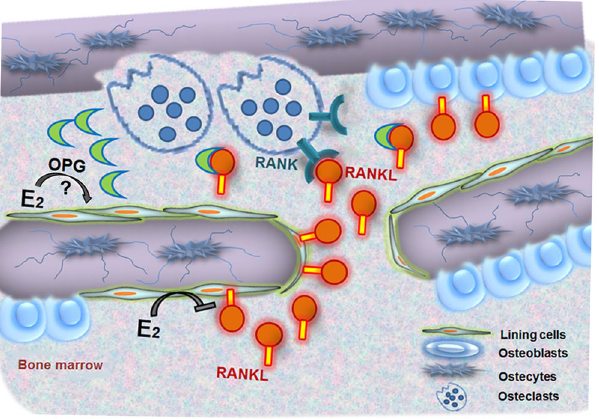
Figure 5. Model of how estrogen regulates osteoclastic bone resorption. Estradiol (E2) primarily suppresses RANKL expression in bone lining cells. Membrane-bound or soluble RANKL interacts with RANK expressed on mature osteoclasts and osteoclast precursors to stimulate bone resorption. The decoy receptor osteoprotegerin (OPG) binds and, thus, biologically inactivates membrane-bound and soluble